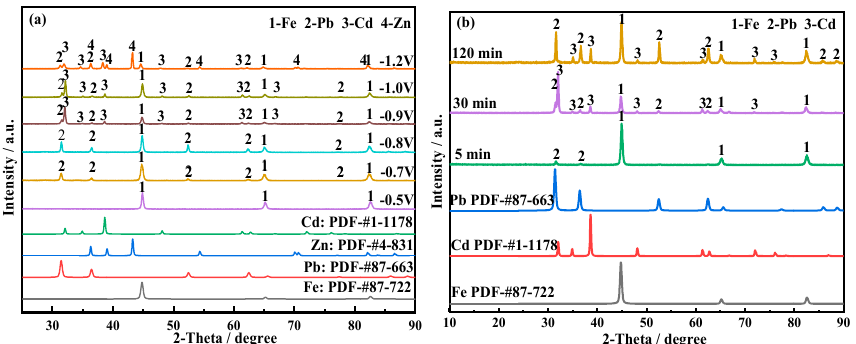
Figure 6. ( a ) The XRD pattern of the cathode plate after 30 min of electrodeposition at different potentials. ( b ) The XRD pattern of deposition products at different deposition times at − 0.9 V ( T = 30 °C).